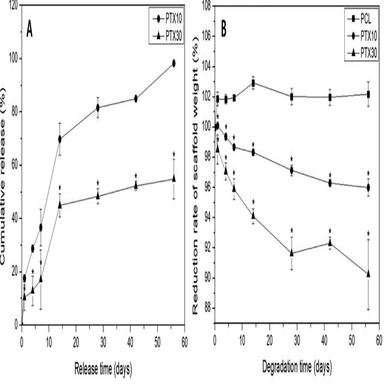
Cumulative drug release profile of PTX/PCL scaffolds with different drug concentrations under biomimetic bile perfusion system (A: cumulative drug release profile rate (%), B: cumulative weight change rate of total scaffold (%)) (A: \p < .01 compared with the PTX10 group, B: \p < .01 compared with the PCL group).